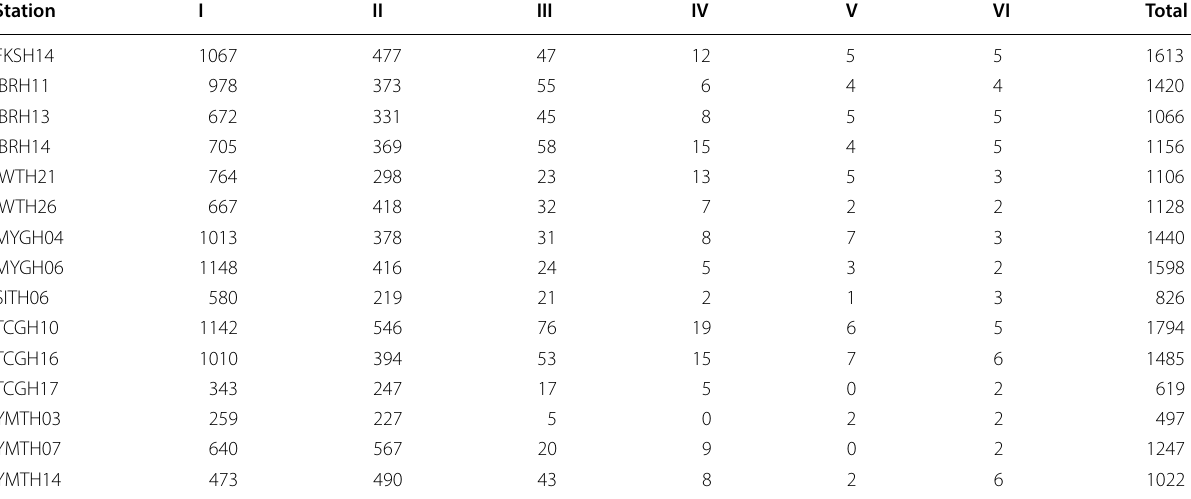
Table 3 Number of seismic records with different rainfall classes